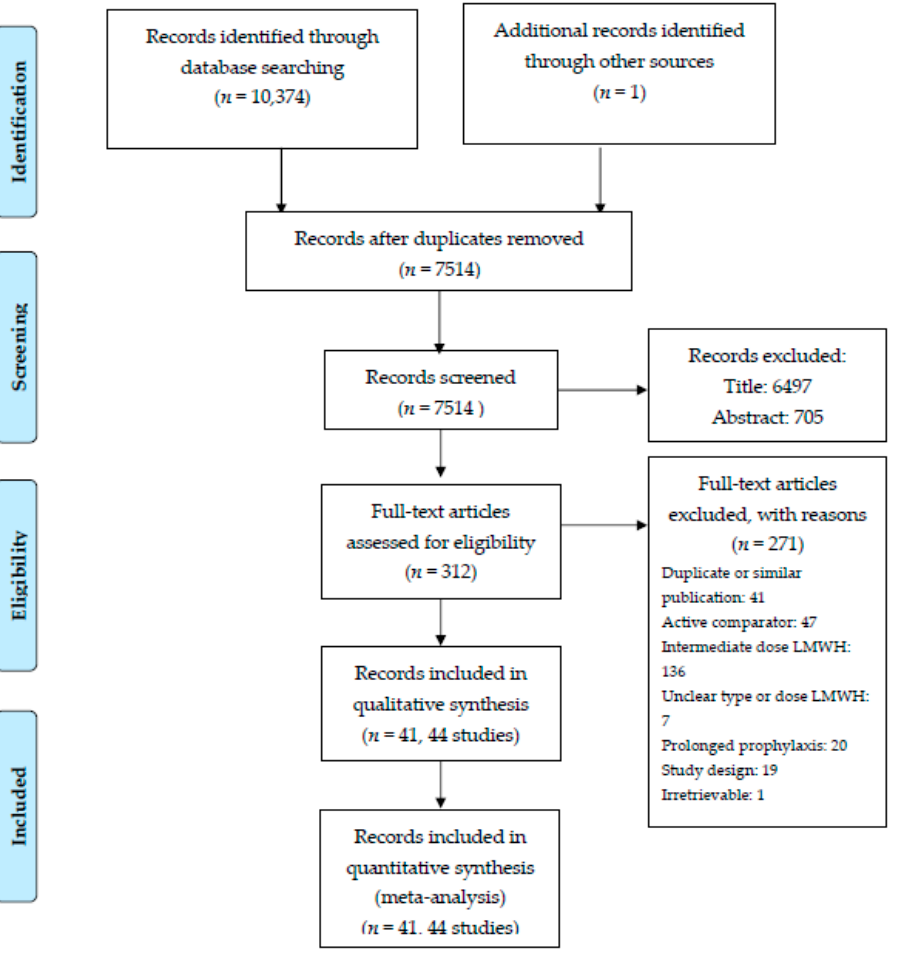
Figure 1. Preferred reporting items for systematic reviews and meta-analyses (PRISMA) flow-chart of study inclusion.